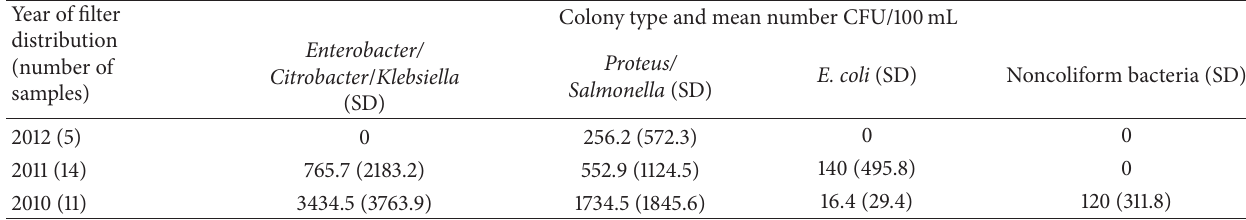
Table 3: Mean bacterial colony count (CFU/100mL) by bacterial type and year of filter distribution.